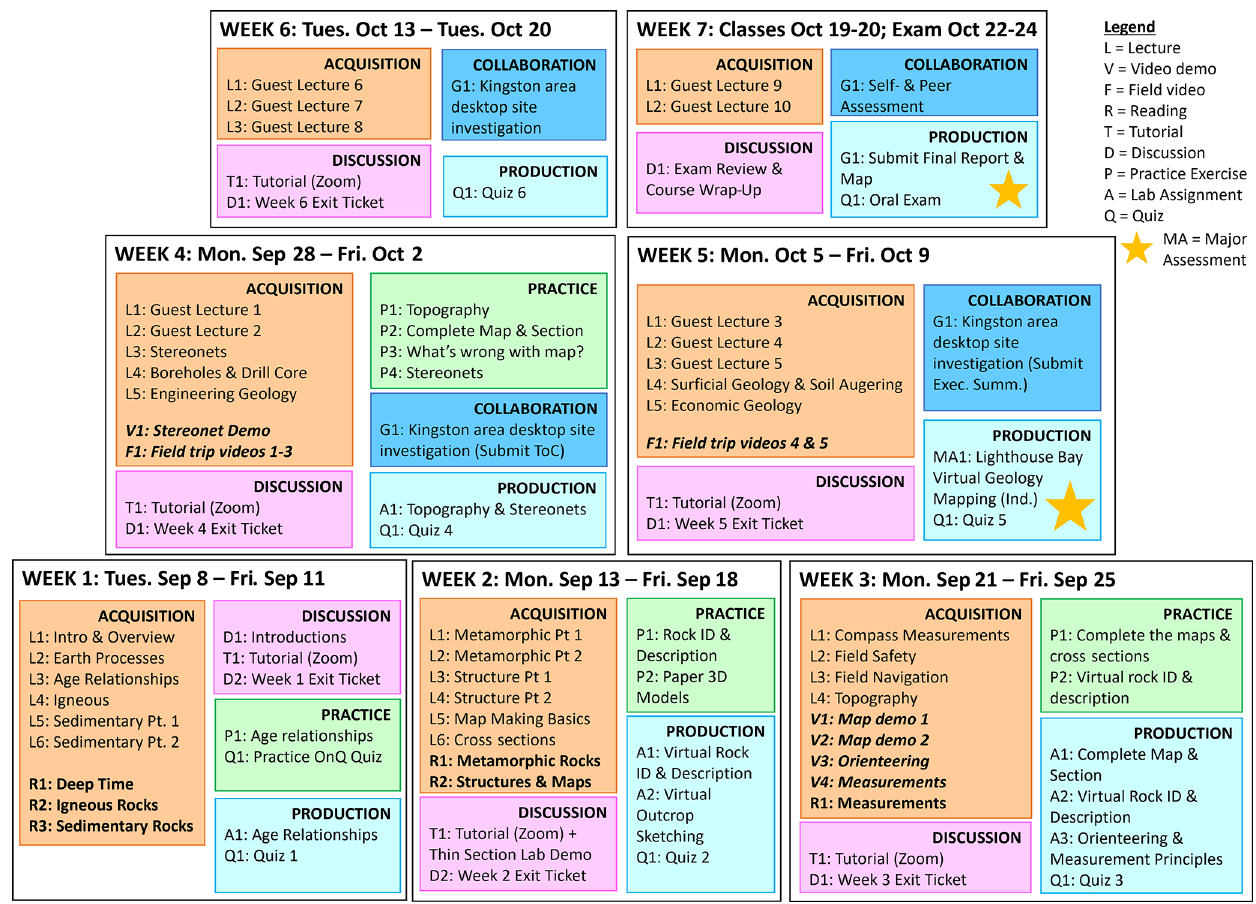
Figure 2. Hybrid linear–spiral curriculum model storyboard of GEOE/L 221 in fall 2020 with remote delivery showing weekly course activities and